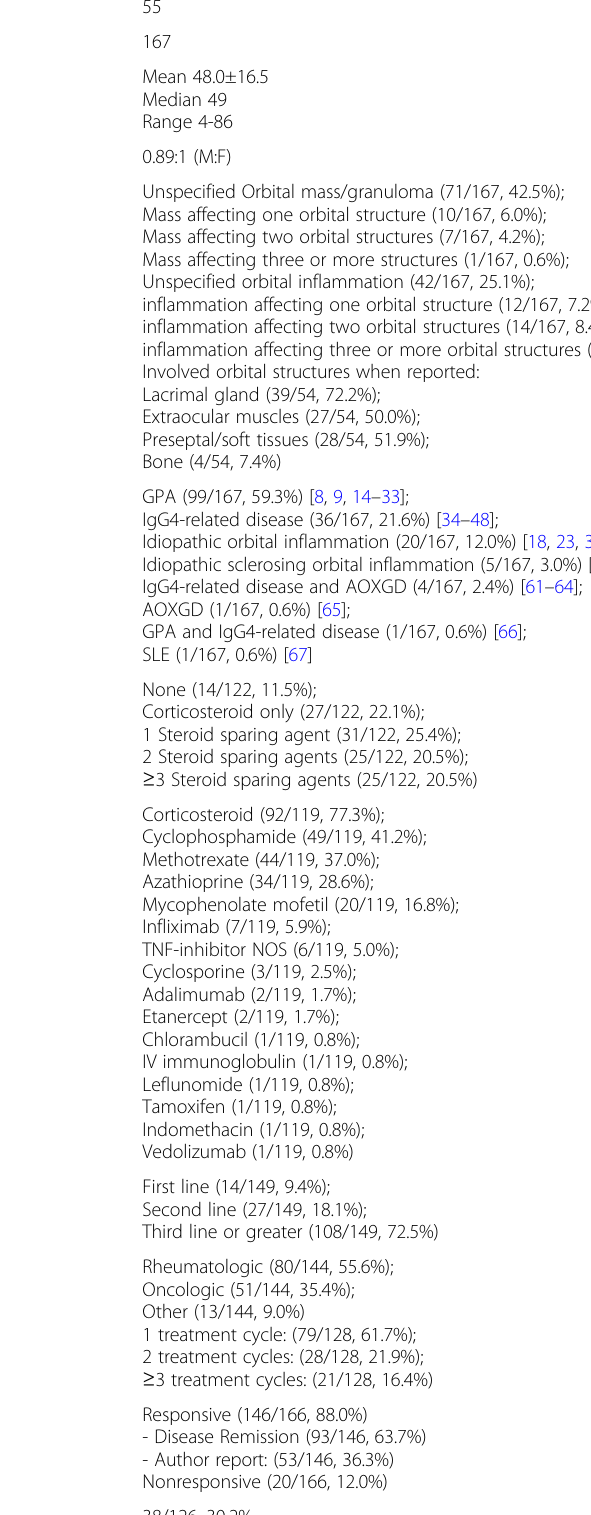
Table 1 Rituximab use in refractory non-infectious orbital inflammation - summary of comprehensive literature